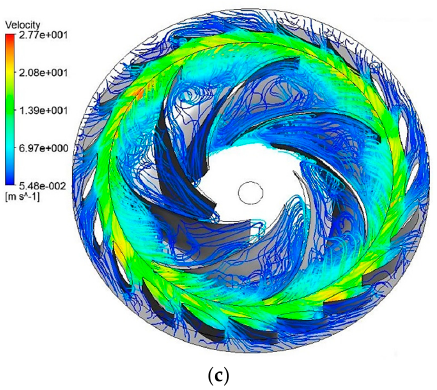
Figure 10. Streamlines in the guide vanes and runner. ( a ) Best efficiency point (OP1); ( b ) runaway point (OP5); and ( c ) low-discharge point (OP6).